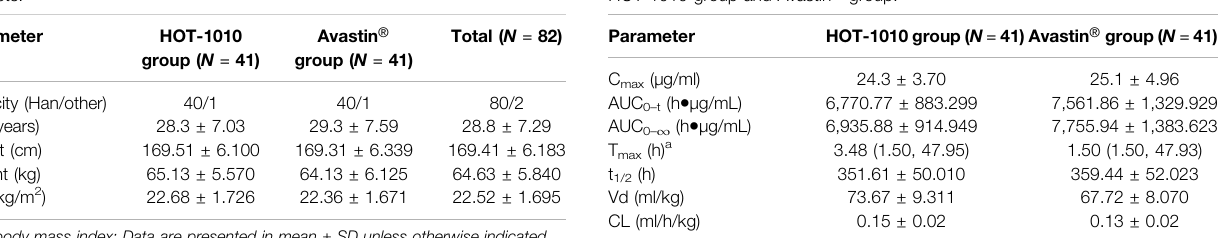
TABLE 2 | The primary pharmacokinetic parameters of bevacizumab between HOT-1010 group and Avastin ®